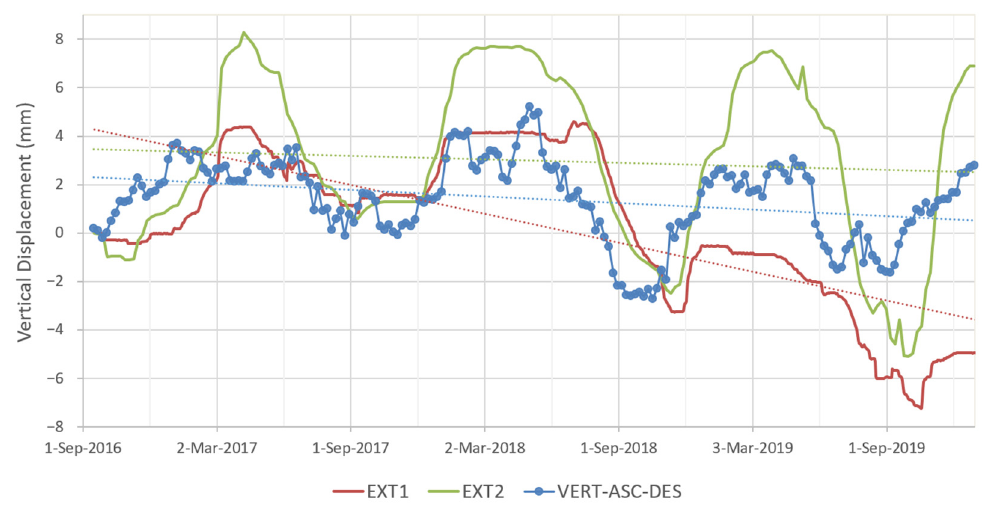
Figure 2. Comparison of the in situ vertical displacement of both extensometers (EXT1 and EXT2) to VERT-ASC-DES, the vertical displacement using the ascending and the descending track of Sentinel-1 at West Point (WP). The linear trendlines of the displacements are also shown (dotted lines). During the three-year period, the ground displacement time-series may be decom- posed with the addition of a linear trend component T, a seasonal component S and an irregular residual component. There is a linear trend with a shrinking of about − 2.2 mm/yr